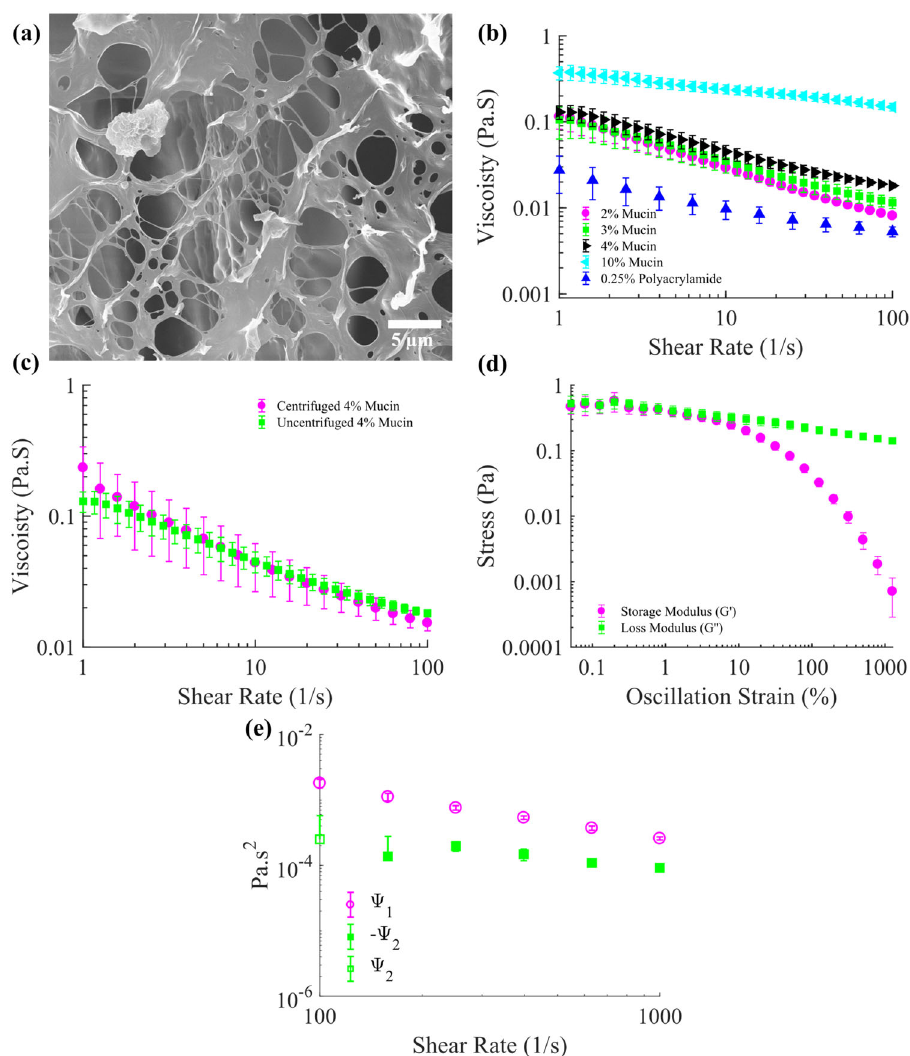
Fig. 5 Rheological characterizations of synthetic mucus and polyacrylamide. a Scanning electron microscopy (SEM) image of synthetic mucus; similar images were produced in two other mucin samples. b Viscosity vs. shear rate curves for different concentrations of mucin and 0.25% polyacrylamide. c Comparison of centrifuged and uncentrifuged 4% mucin formulations. d Evolution of storage modulus (Pa) and loss modulus (Pa) with increasing oscillation strain for 4% mucin; frequency was fi xed at 10 Hz during this experiment. e First ( ψ 1 ) and second ( ψ 2 ) normal stress coef fi cients for 10% mucin with theoretical inertial correction (see Supplementary Note 10). Three independent trials were performed for individual concentrations in ( b ), three independent trials were used for data shown in ( c , e ), and four independent trials were performed for ( d ). Data are presented as mean ± standard deviation. Source data are provided as a source data fi